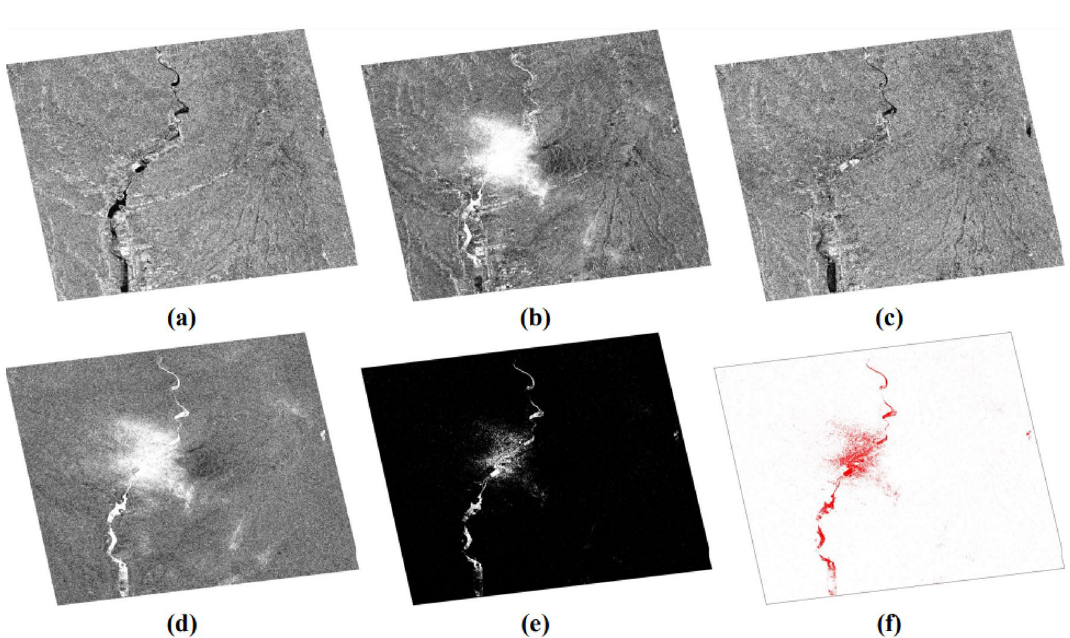
Figure 5. Extraction of high moisture/roughness surfaces from a combination of VV and VH; ( a ) σ0 VV/VH , 14/05/2020; ( b ) σ0 VV/VH , 20/05/2020; ( c ) σ0 VV/VH , 01/06/2020; ( d ) extraction moisture/roughness downpour, 20/05/2020; ( e ) discrimination moisture/roughness downpour area, color white, 20/05/2020; ( f ) moisture/ roughness downpour area, color red,